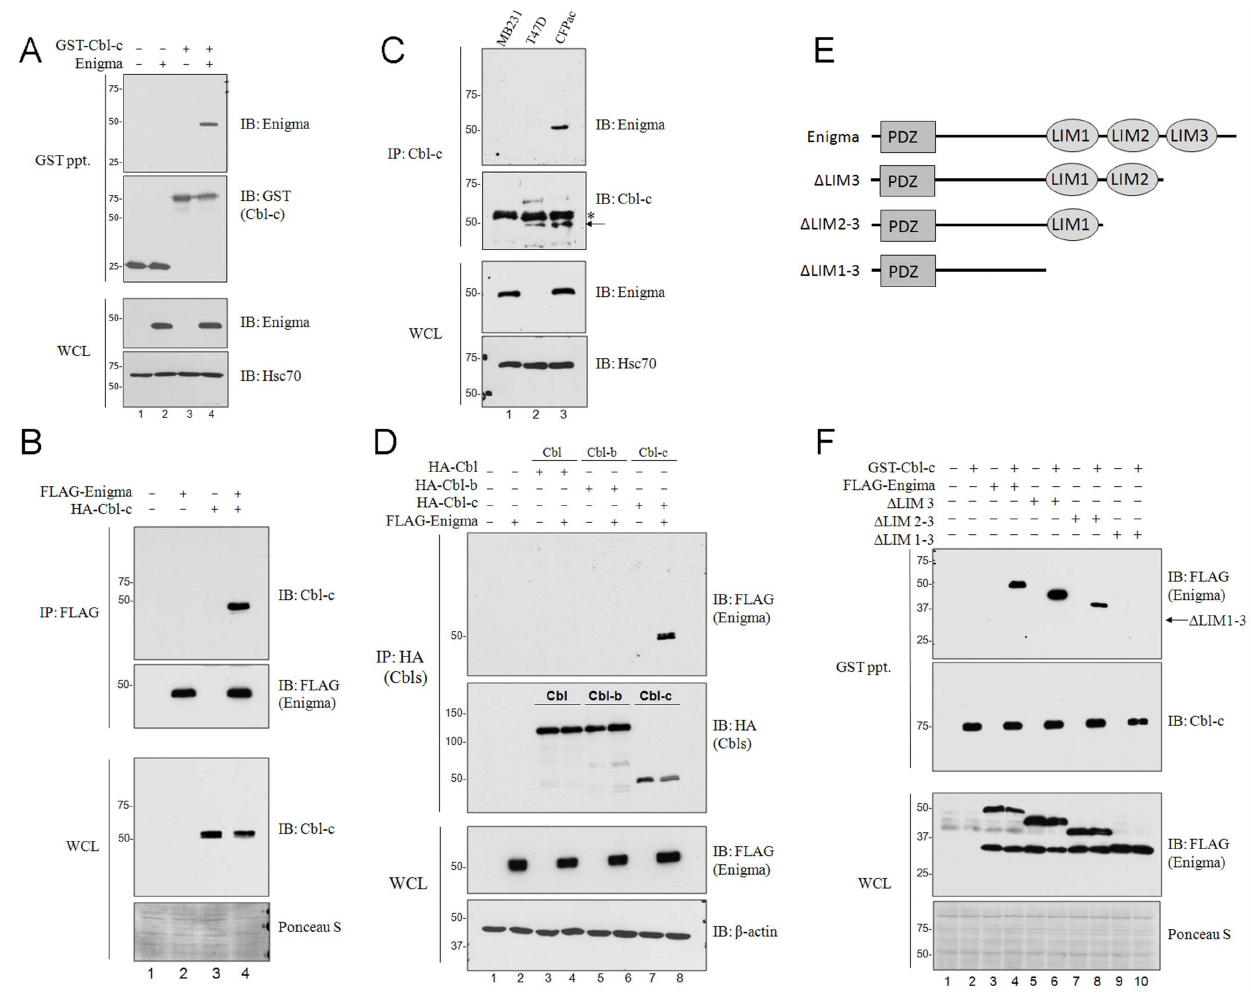
Figure 1. Enigma interacts with Cbl-c. ( A ) HEK293T cells were transfected with GST, or GST-Cbl-c with and without untagged human Enigma as indicated above each blot. All transfections were balanced with empty vector controls and whole cell lysates were collected at 48 h post-transfection. GST pull-downs were performed using 300 m g of whole cell lysates. GST pull-downs (GST ppt.) and whole cell lysates (WCL) were immunoblotted (IB) as indicated to the right of each blot. Molecular weight standards in kDa are indicated to the left of each panel and Hsc70 is shown as a loading control. ( B ) HEK293T cells were transfected with HA-Cbl-c with and without FLAG-Enigma as indicated above each blot. Immunoprecipitations were performed using anti-FLAG-M2 agarose with 300 m g of whole cell lysates. IPs and WCL were immunoblotted as indicated to the right. Molecular weight standards are indicated to the left of each panel and Ponceau S staining serves as a loading control. ( C ) Immunoprecipitation of endogenous Cbl-c was performed on whole cell lysates from three human cell lines: 30mg of MB-231, a triple negative breast cancer cell line; 30mg of T47D, a human ER + breast cancer cell line; and 20mg of CFPac-1, a human pancreatic cancer cell line. Immunoprecipitations using rabbit anti-Cbl-c conjugated sepharose, were immunoblotted for endogenous Cbl-c (indicated by arrow) and for endogenous Enigma as indicated. Rabbit immunoglobulin is indicated with an asterisk (*) and molecular weight standards are indicated on the left of each panel. Whole cell lysates were immunoblotted for endogenous Enigma and Hsc70 which serves as a loading control. ( D ) HEK293T cells were transfected with HA-Cbl, Cbl-b, or Cbl-c with and without FLAG-Enigma. Cbl immunoprecipitations were performed on 300 m g of each of the whole cell lysates using anti-HA affinity matrix and immunoblotted for co-immunoprecipitation of Enigma, as indicated. Whole cell lysates were immunoblotted as indicated and molecular weight standards are indicated on the left of each panel. b -actin serves as a loading control. ( E ) Enigma truncation constructs used for mapping Cbl-c interaction site. ( F ) HEK293T cells were co-transfected with GST-Cbl-c along with FLAG-Enigma, D LIM3, D LIM2-3, or D LIM1-3. Whole cell lysates were collected and immunoblotted for Enigma constructs with anti-FLAG and for Cbl-c as indicated on the right. GST pull-downs were immunoblotted for GST-Cbl-c with anti-GST and for each of the FLAG-Enigma proteins as indicated. Arrow indicates expected position of D LIM1-3 protein. Molecular weight standards are indicated on the left of each panel and Ponceau S staining serves as a measure of protein loading.